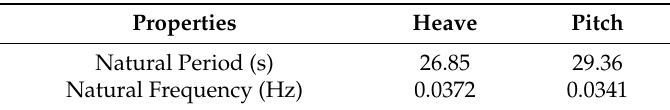
Table 6. Damped natural period of the FOWT-SFFC without mooring forces.